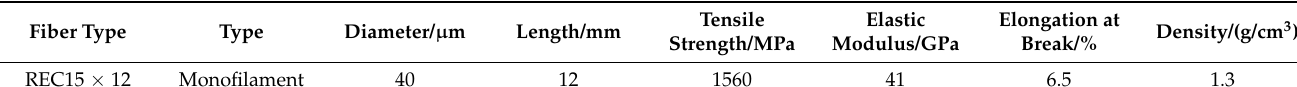
Table 3. Physical and mechanical indicators of PVA fiber.